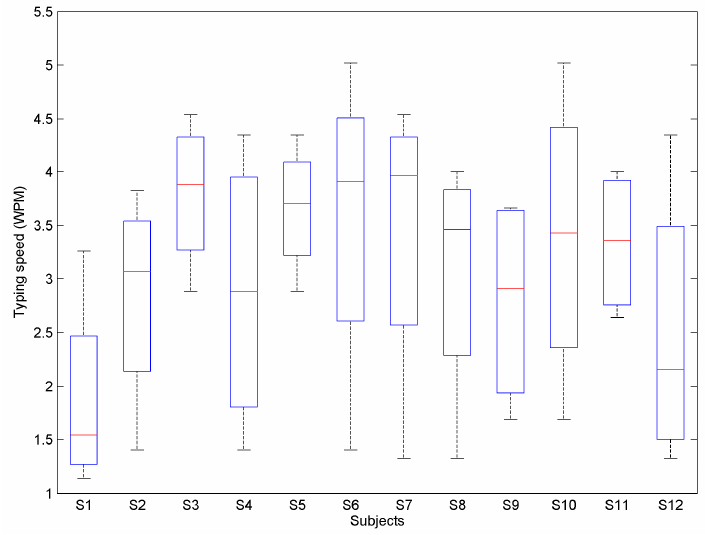
Figure 9. Gesture typing performance of all subjects.